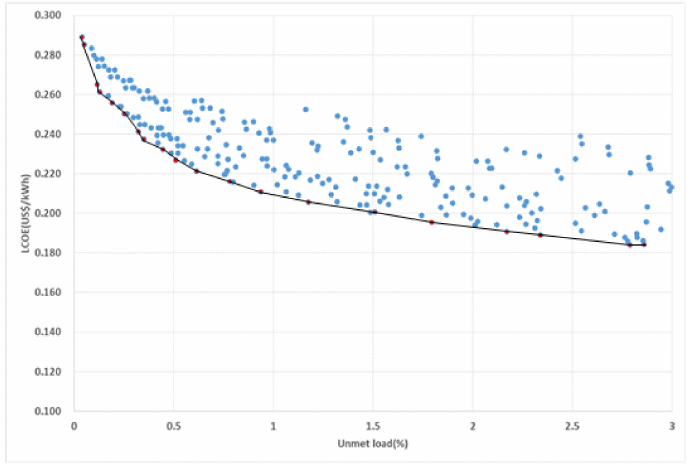
Figure 6. Unmet load and LCOE distribution under S2.